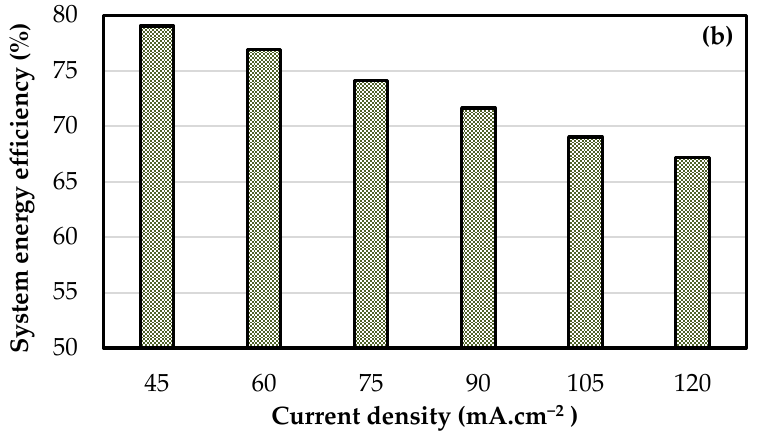
Figure 9. Electrochemical performance of 8 cell—1500 cm 2 stack at different current densities at a constant electrolyte flow rate of 0.30 mL.min −1 .cm −2 : ( a ) discharge capacity and energy density and ( b ) system energy efficiency.